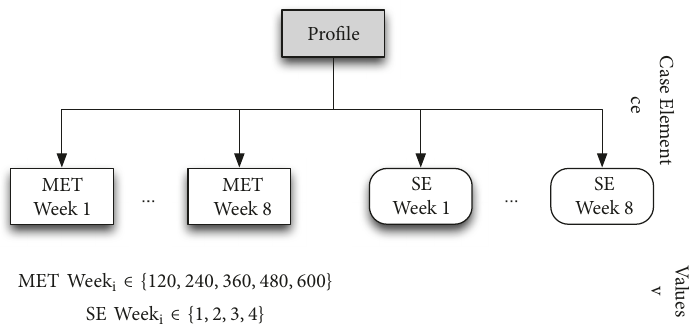
Figure 6: The case structure of our case study.